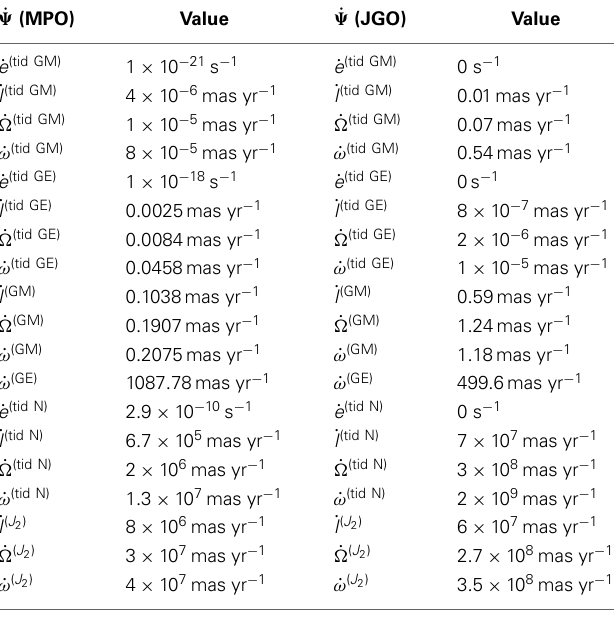
Table 2 | Maximum nominal values of the direct orbital rates of change ˙ (cid:2) of MPO and JGO, averaged over both P b and P (cid:2) b , induced by the post-Newtonian gravitoelectric and gravitomagnetic tidal field of M (cid:2) , by its Newtonian tidal field, and by some competing Newtonian and post-Newtonian perturbations due to the deviation from spherical symmetry of the field of M